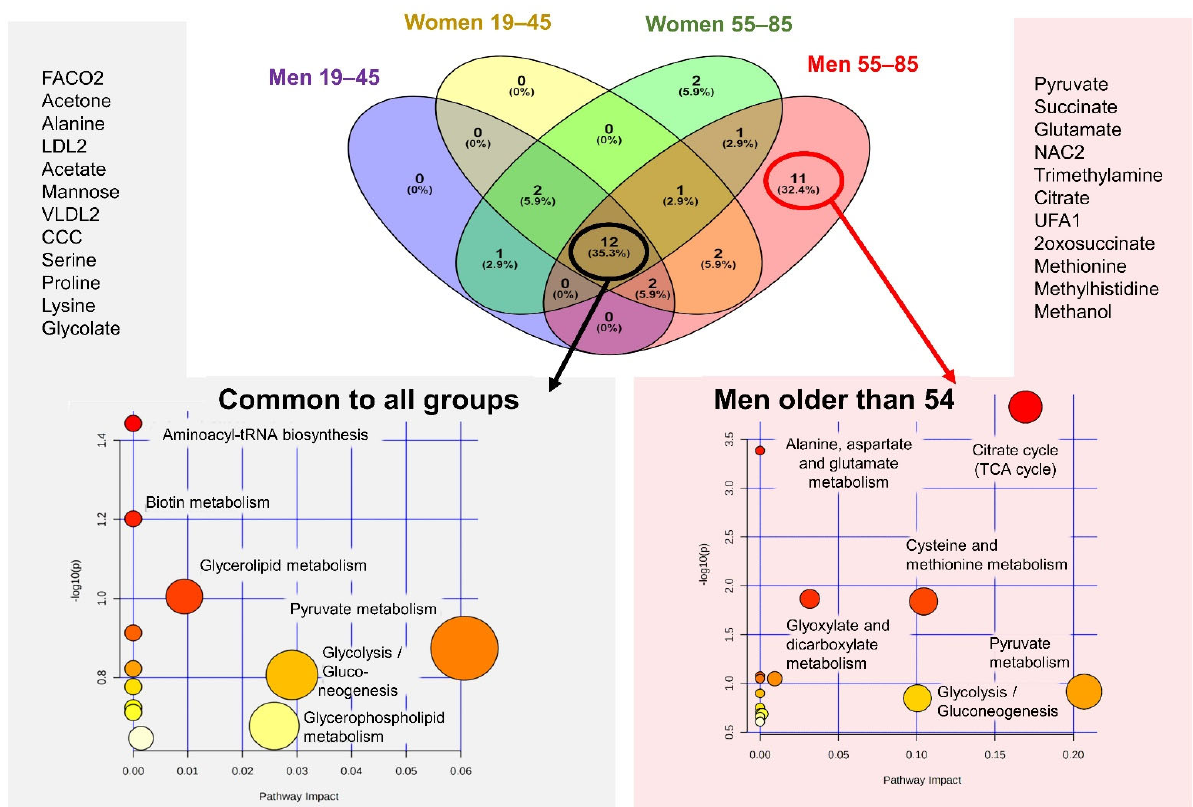
Figure 5. Metabolic pathways affected in MetS5 in all groups. Venn diagram of the metabolites identified as altered in MetS.5 with respect to MHO in the different age and sex groups, and pathway enrichment analysis of all groups’ intersections and the metabolic specific for men older than 54. For each subgroup (represented by ovals of different colors) is shown the number of the metabolites that are common to two, three or all the four groups (where ovals overlap) or those that are exclusive to each group (outer ovals). Metabolic pathway enrichment analysis for metabolites common to all groups (left, grey background) and exclusive for men over 54 years old (right, pink background) are also represented. Metabolic pathways whose name is indicated are significant ( p ‐ value lower than 0.05 after the adjustment using Holm ‐ Bonferroni method and False Discovery Rate) and have a pathway impact value, calculated from pathway topology analysis, over 0. The x ‐ axis indicates the impact on the route, while the y ‐ axis indicates significant changes to a route. The pathways are represented as circles. The circle color indicates the significance level, from highest (red) to lowest (white) in the enrichment analysis. The circle size is proportional to the impact value of each road from the topology analysis.